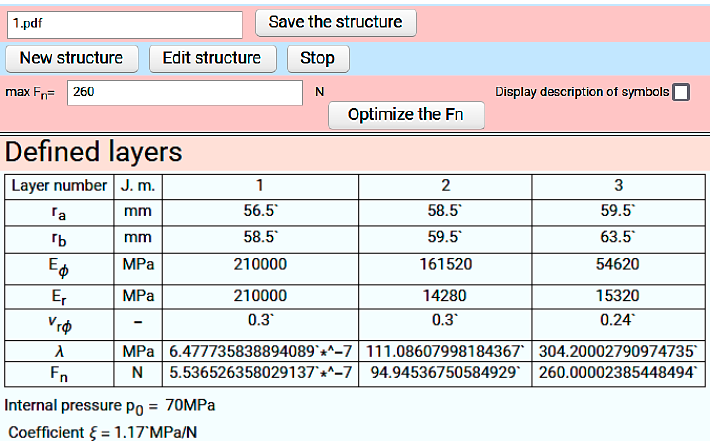
Figure 26. Dialogue window of calculation results. The colour of the graphs represents: ― stresses due to internal pressure, ― stresses resulting from the introduction of fibre tension, ― stresses after optimization.